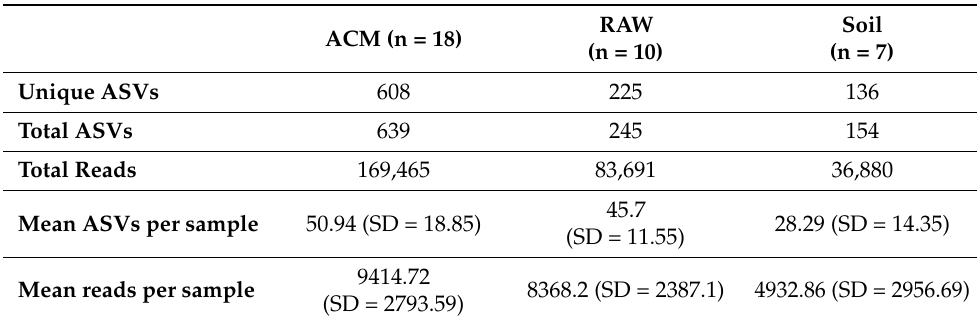
Table 2. Summary of ASV and read numbers, post-processing, for each sample type within the 16S dataset.